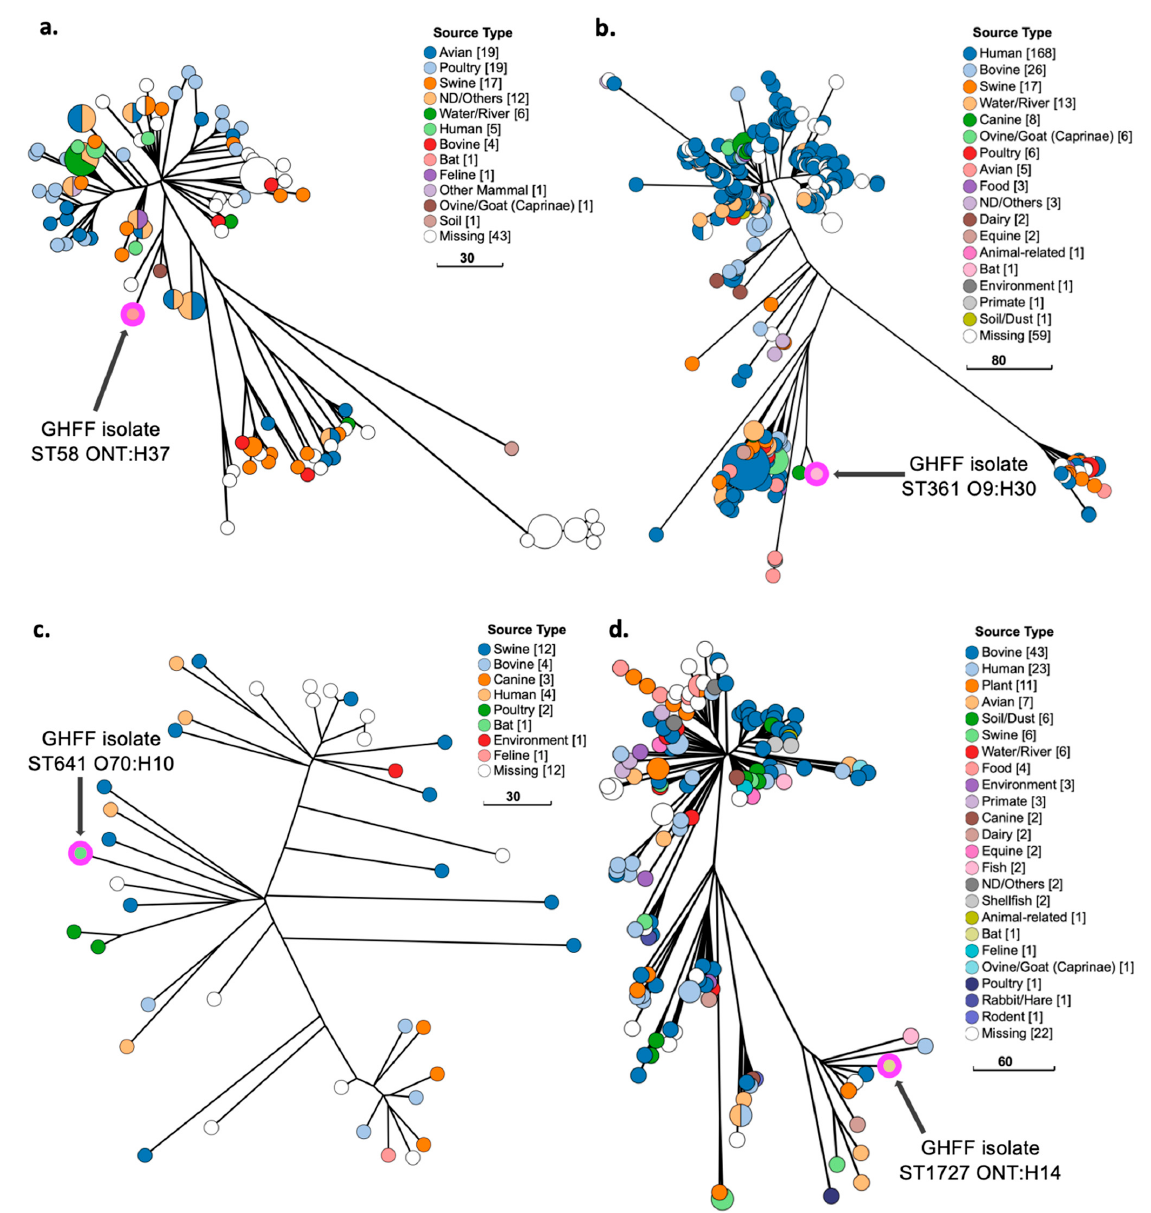
The single ST58 ONT:H37 fimH32 GHFF isolate belonged to an ST58 ONT:H37 BAP4 Supplementary Table S4. ( b ) Core genome SNP analysis and associated metadata tables of Grape- Tree clusters containing GHFF pup isolates. Maximum likelihood trees were based on the RAxML of non-repetitive core SNPs using the EnteroBase SNP Project dendrogram module against the ref- erence genome ESC_QA8493AA (removed from the SNP tree image for clarity). Isolate ID indicates EnteroBase Barcode. Scale bars indicate the number of substitutions per site.